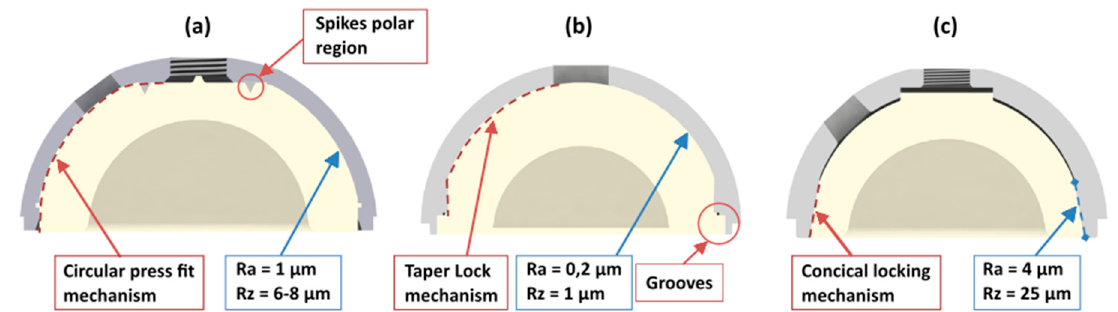
Figure 2. Locking mechanisms and surface specifications of the different cup systems. ( a ) Zimmer Biomet, ( b ) DePuy Synthes, ( c ) Aesculap.